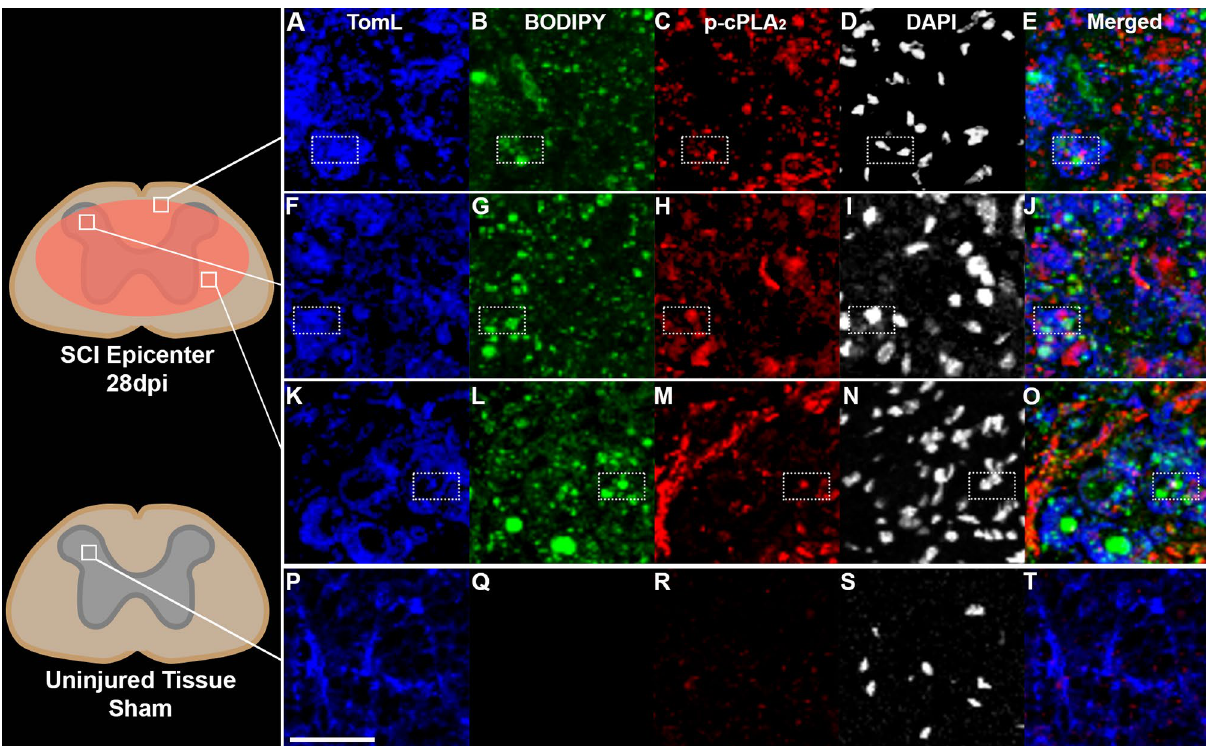
Figure 1. Macrophages can contain both myelin-derived lipids and active cPLA 2 28 days after spinal cord injury (SCI). Ten adult, 4-month-old C57/b female mice received a T9 75kdyn infinite horizons (IH) contusion SCI. ( A – E ) Representative example of TomL positive macrophages (blue) in injured white matter containing both lipid debris (green, BODIPY, staining for neutral lipids) and active p-cPLA 2 (red) (imaged area is represented by box within spinal cord diagram). DAPI (white) was excluded from merged images. ( F – J ) Example of TomL positive macrophages (blue) in injured grey matter containing both lipid debris (green, BODIPY, staining for neutral lipids) and active p-cPLA 2 (red). ( K – O ) Example of TomL positive macrophages (blue) in injured grey matter in the core of the injury epicenter containing both lipid debris (green, BODIPY, staining for neutral lipids) and active p-cPLA 2 (red). ( P – T ) Example of TomL positive macrophages (blue) in uninjured tissue from sham animals with minimal lipid debris or active p-cPLA 2 (red). Boxes indicate examples of triple positive cells. Maximum intensity projection confocal images. Scale bar in image p = 50